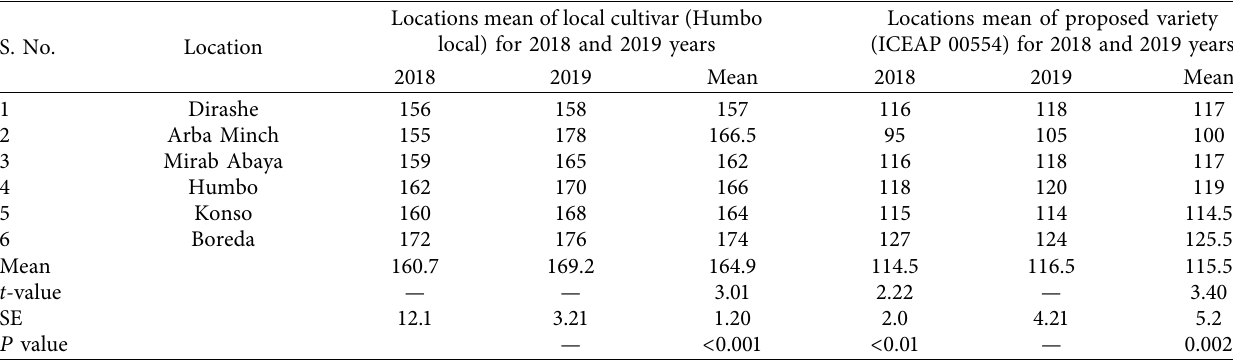
SEM, mean standard error. Table 5: Days to 75% flowering of pigeon pea genotypes across locations during 2018 and 2019 cropping seasons, South Ethiopia. S.